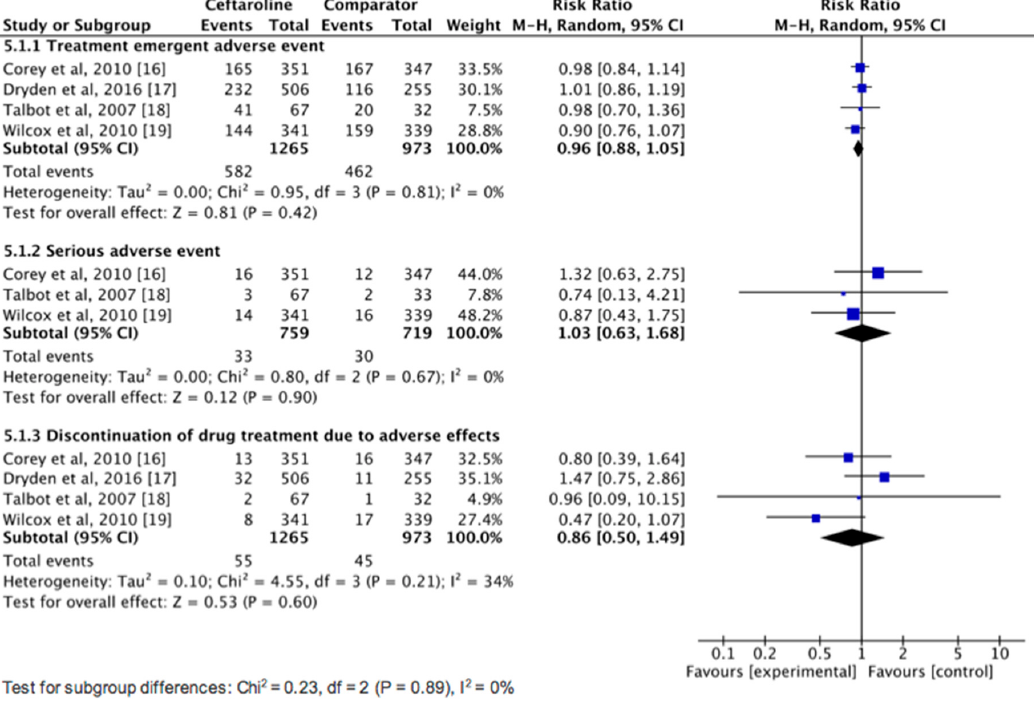
Figure 5. Adverse event risks with ceftaroline and comparators in the treatment of complicated skin and soft tissue infections.